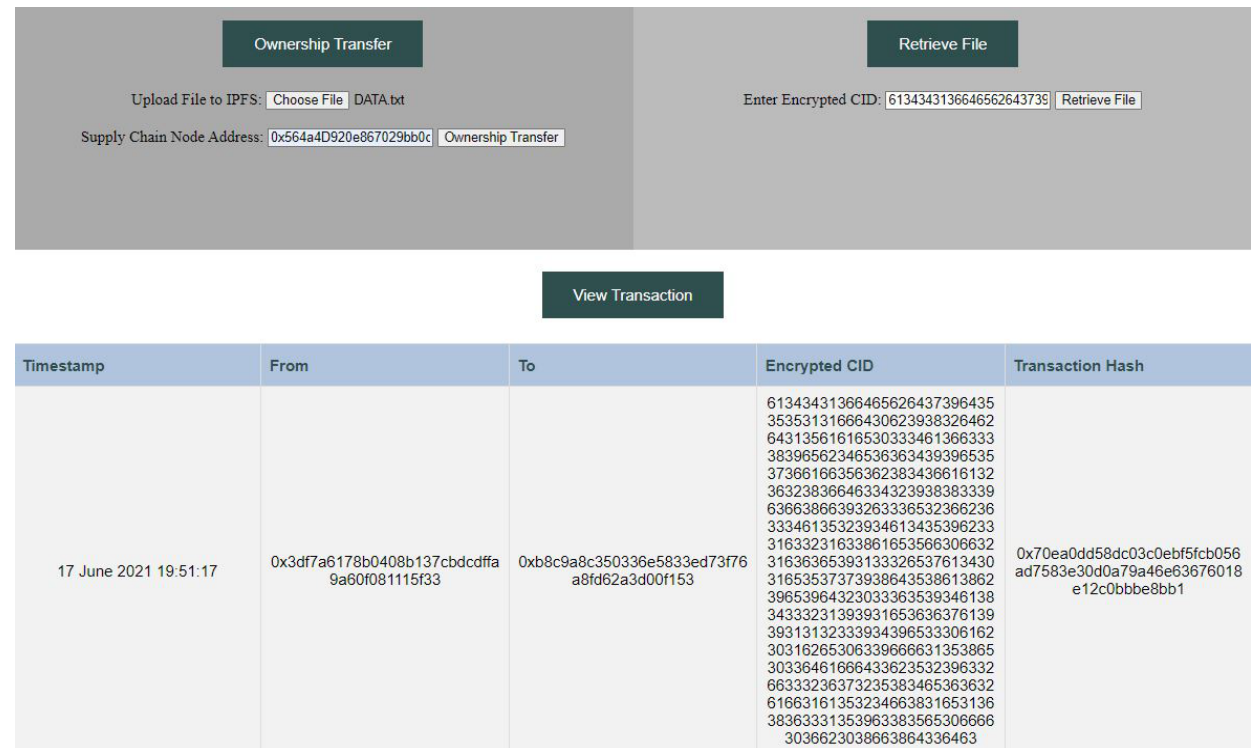
Figure 4. Decentralized web application for RFID tag transfer in a supply chain system.